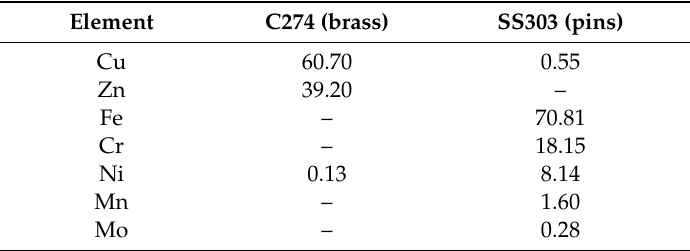
Table 1. Chemical compositions (wt. %) of brass workpieces and stainless steel